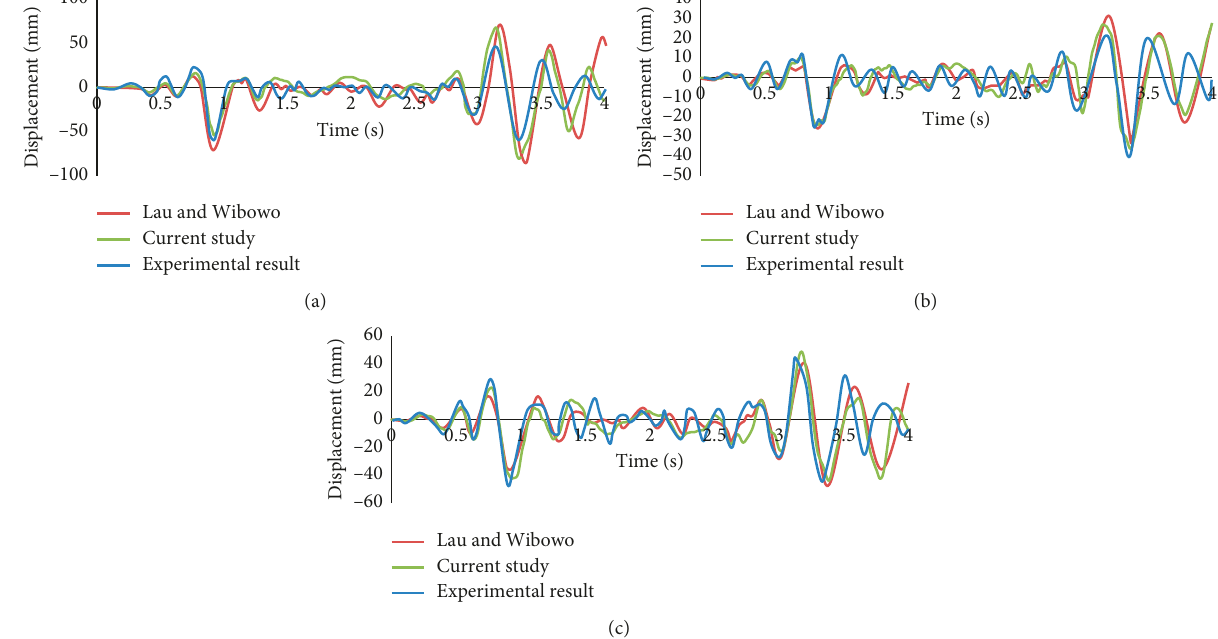
Figure 8: Comparison of the response of the bridge (b213) (linear box girder) in the current research, with the research of Lau and Wibowo [3] and experimental study [17] for (a) short, (b) medium, and (c) tall piers.